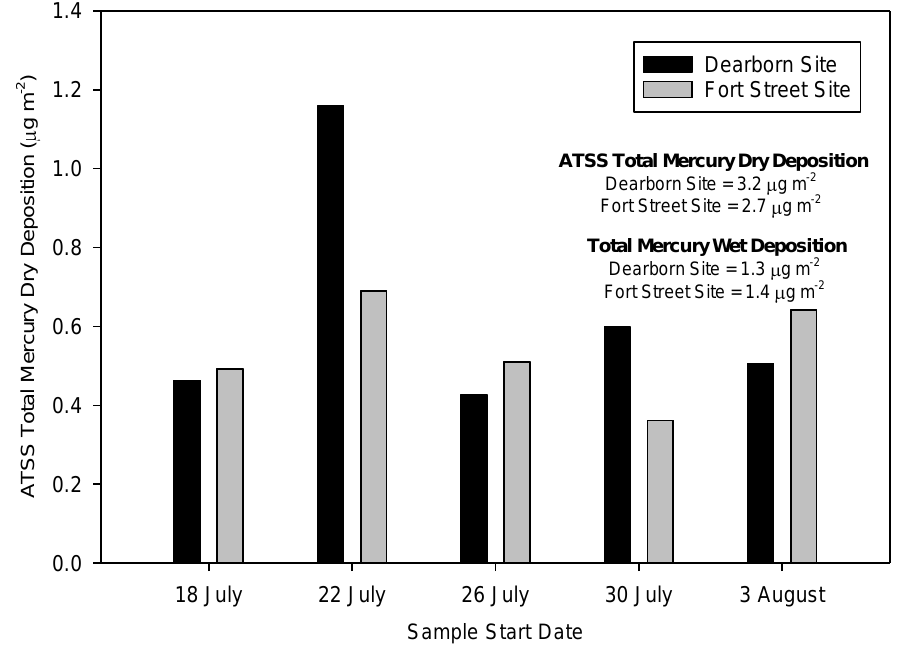
Figure 3. Spatial Evaluation of Artificial Turf Surrogate Surface (ATSS) Total Mercury Dry Deposition Results Between Detroit and Dearborn, MI Monitoring Sites.